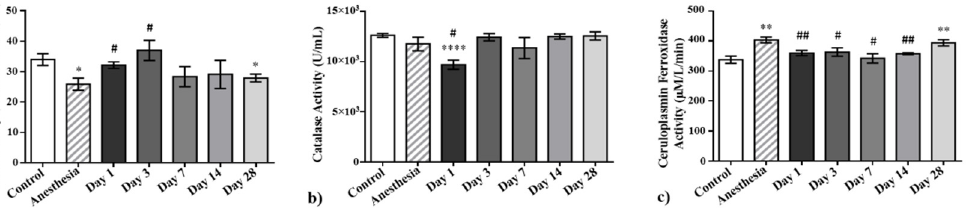
Figure 3. The activities of superoxide dismutase ( a ) and catalase ( b ), as well as the ferroxidase activity of ceruloplasmin ( c ), in the plasma samples of control and irradiated animals measured on the 1st, 3rd, 7th, 14th, and 28th days after irradiation with the laser-driven UPEB. * p < 0.05; ** p < 0.01; **** p < 0.0001; # p < 0.05; ## p < 0.01 (* compared to control; # compared to anesthesia).